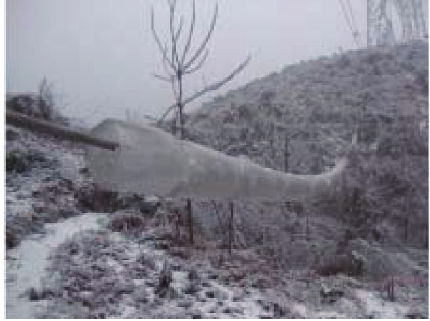
Figure 12: Accreted ice of the transmission line